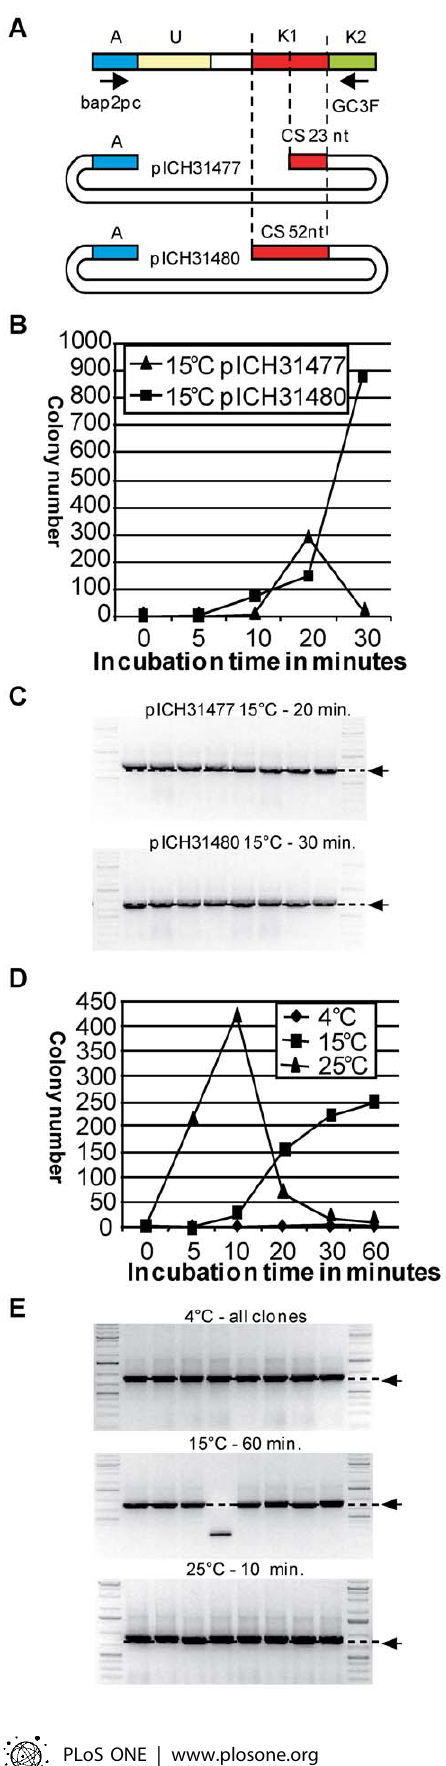
Figure 5. Test of CS length, reaction temperature and incubation time. ( A ) To analyze the influence of the catching sequence length on cloning efficiency, the T019 GC3F PCR product was cloned into pICH31477 (23 nucleotide CS) and pICH31480 (52 nucleotide CS). Cloning was performed using an incubation at 15 u C for 0, 5, 10, 20 and 30 minutes (A, adaptor; U, unknown sequence; K, known sequence; CS, catching sequence) ( B ). ( C and E ) Eight randomly chosen clones from reactions with the incubation times that yielded the most clones were analyzed by colony PCR using vector primers. The PCR products were separated on a 1% agarose gel supplemented with ethidium bromide and visualized under UV light. The expected insert size is indicated by an arrow. ( D ) To determine the optimal incubation temperature and time, the T019 GC3F PCR product was cloned into pICH31480 (52 nucleotide CS) using incubation temperature of 4 u C, 15 u C and 25 u C for 0, 5, 10, 20, 30 and 60 minutes.